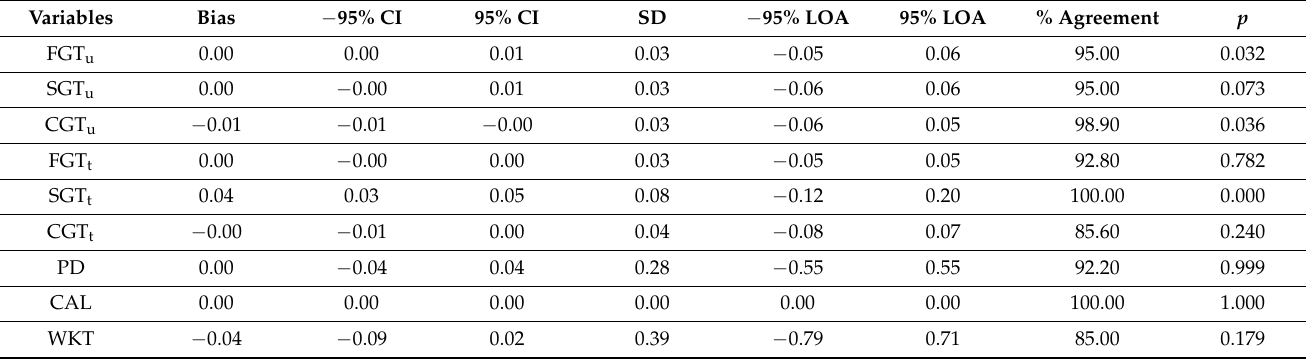
Table 2. Intra-examiner agreement of measurement performed by the first examiner